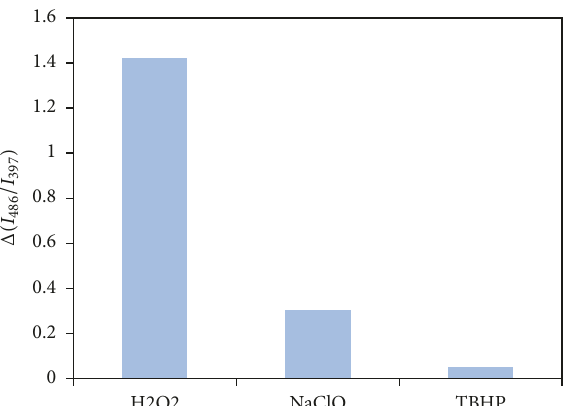
Figure 3: Comparison of the relative change in excimer (486 nm) to monomer(397 nm)emissionintensityratiosagainstreactiveoxygen species (30 𝜇 M each) for aqueous solutions of B-11 buffered by 5 mM Na 2 CO 3 /5mM NaHCO 3 (pH 10.2).